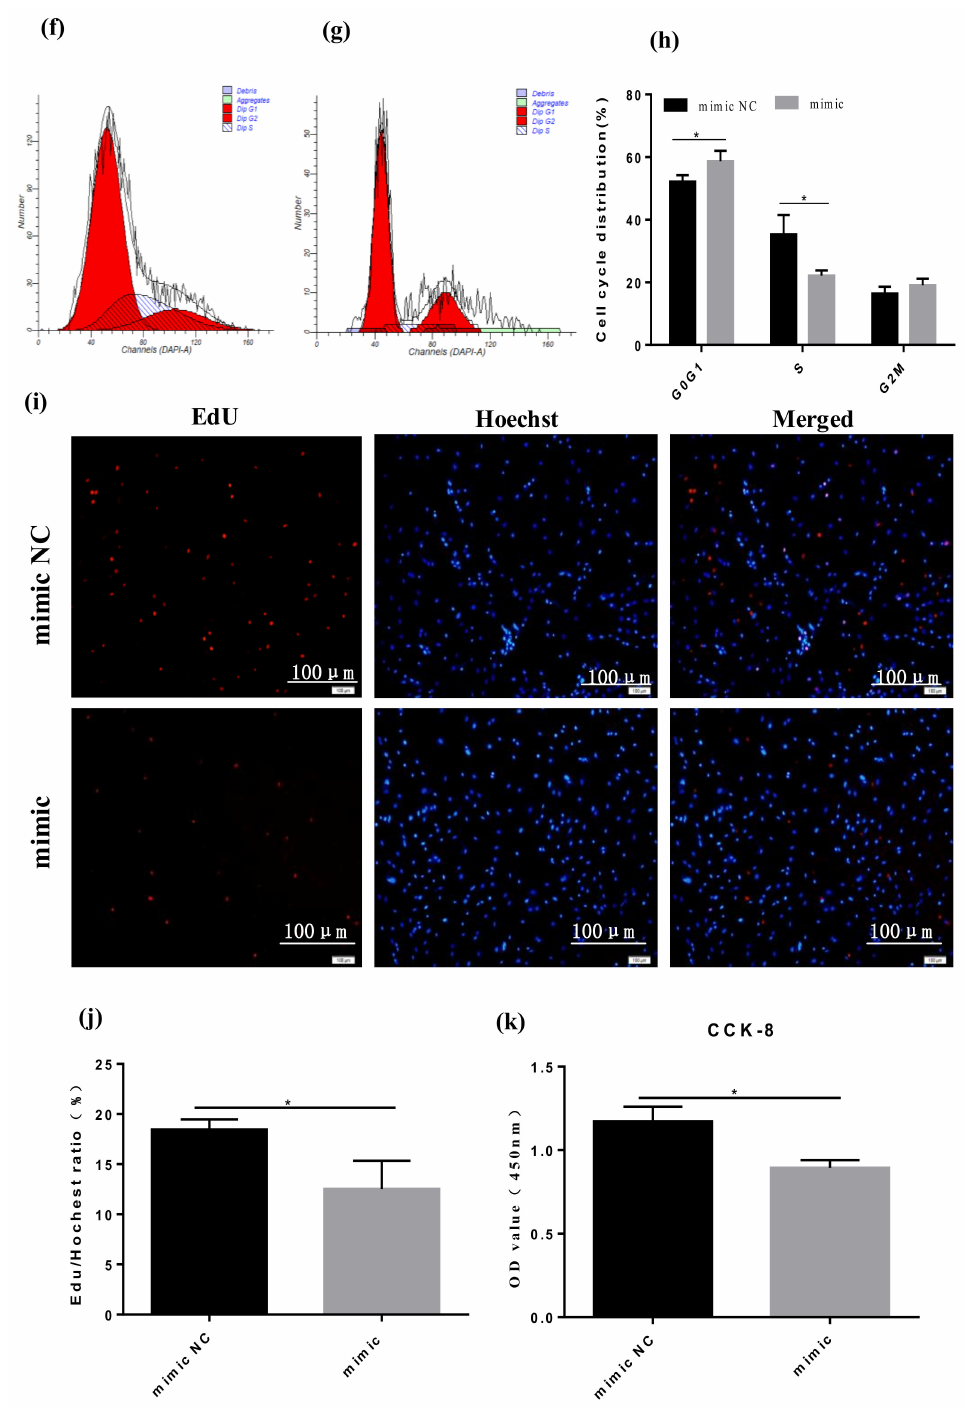
Figure 2. Bta-miR-376a inhibited the proliferation of Qinchuan beef preadipocytes. ( a1 – a3 ) Using the evos-fl-auto2 automatic living cell fluorescence microscope imaging system (Thermo Fisher, Waltham, MA, USA) to collect Cy3 fluorescence for 12, 24, and 48 h to detect the transfection status of the entire cell experiment and ensure that the transfection reagent is e ff ective. ( b ) Quantified results of transfection e ffi ciency detection of bta-miR-376a. ( c – e ) RT-qPCR and Western blot were used to analyze the expression of genes ( PCNA , CDK1 , CDK2 ) which associated with cell cycle. ( f – h ) Flow cytometry was used to analyze the cells 48 h after transfection, and the cell cycle analysis charts of di ff erent cell cycles were compared. ( i , j ) EdU assay was performed 48 h after transfection. Red: EdU (Cells during DNA replication); blue: Hoechst (the cell nuclei). ( k ) The amount of cells was analyzed by CCK-8. Data are expressed as mean ± SEM, * p ≤ 0.05, ** p ≤ 0.01, *** p ≤